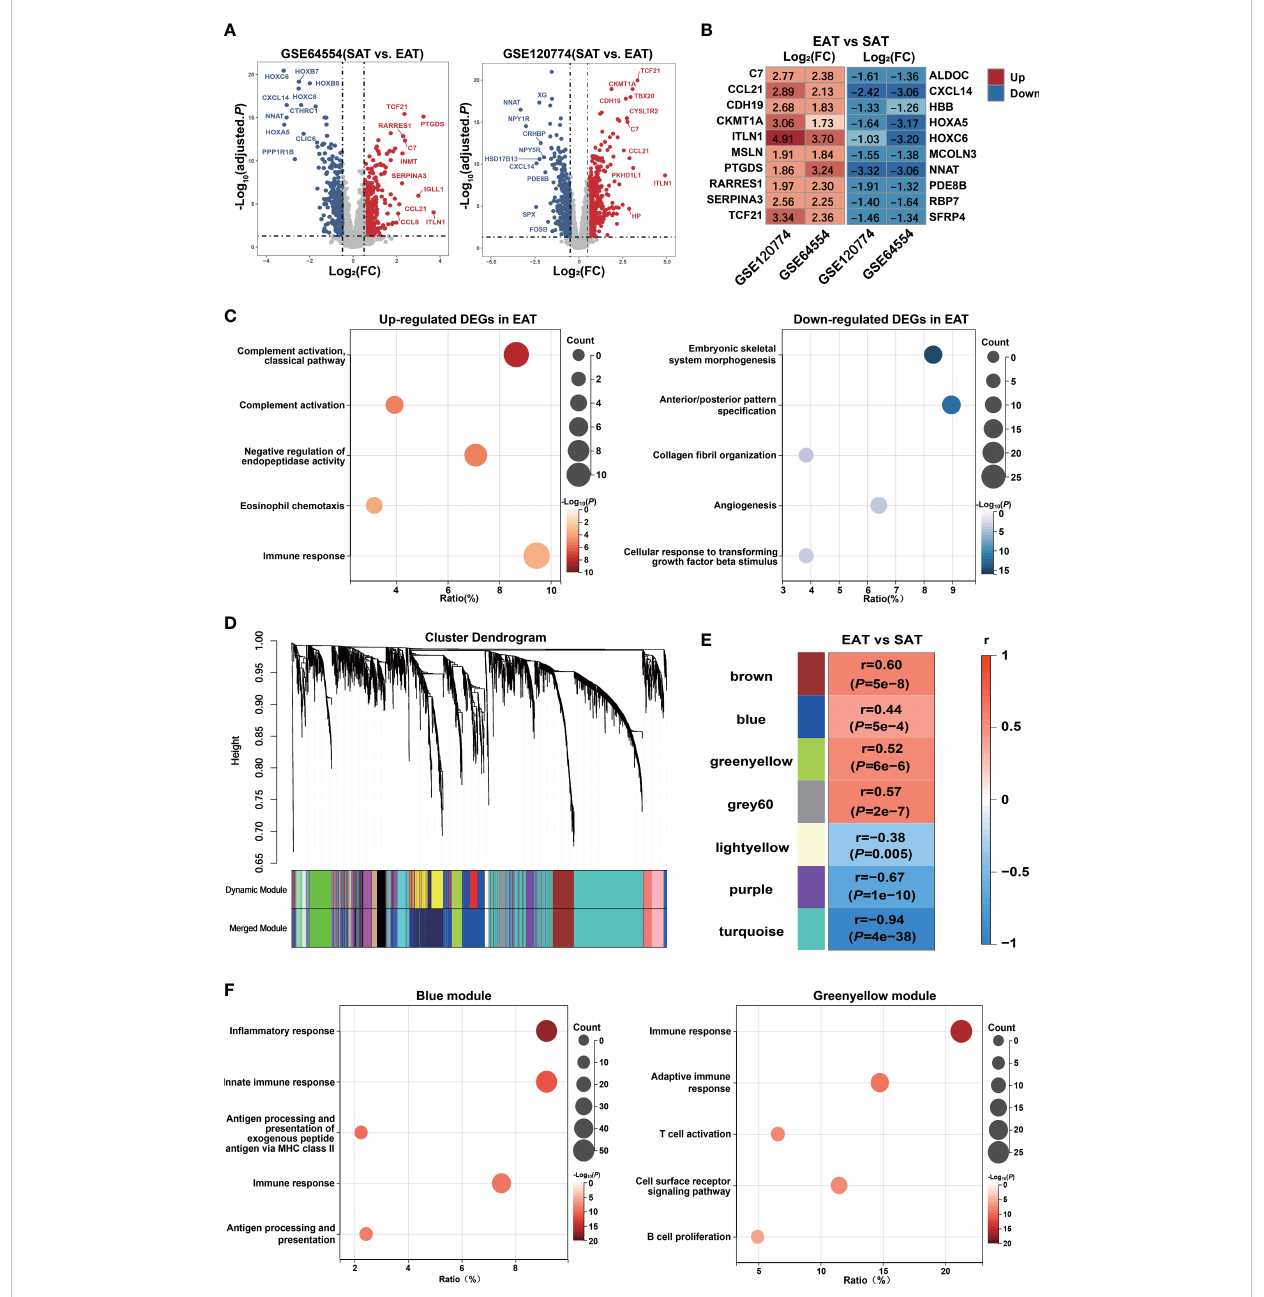
FIGURE 2 Bioinformatics analyses reveal pro-in fl ammatory characteristics and key genes of EAT. (A) Volcano plot of DEGs between EAT and SAT in GSE64554 and GSE120774. (B) Top 10 up- and down-regulated DEGs identi fi ed by RRA method. (C) GO-BP functional enrichment analyses of up- and down- regulated DEGs in EAT compared to SAT. (D) Cluster dendrogram of WGCNA. (E) WGCNA key modules and EAT/SAT phenotype correlation. (F) GO- BP functional enrichment analyses of WGCNA-identi fi ed blue and greenyellow gene